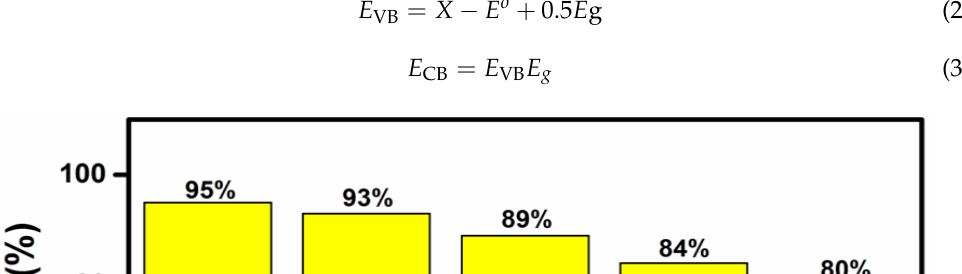
5.79 eV for Mn-ZnO [37], E o is the hydrogen scale free electron energy which has ∼ 4.5 eV value, and E g is the energy band gap. As Mn-ZnO ( − 0.25 eV vs. NHE) has more conduction band potential as compared to Ag 3 PO 4 (+0.329 eV vs. NHE), electrons were shifted from the conduction band of Mn-ZnO toward the conduction band of Ag 3 PO 4 [38,39]. Moreover, holes were shifted from the valence band of Mn-ZnO (+2.83 eV vs. NHE) to the valence band of Ag 3 PO 4 (+2.589 eV vs. NHE) due to p–n heterojunctions [40]. In this way, the formed Type-II p–n junction between Ag 3 PO 4 and Mn-ZnO facilitated the charge carrier transportation efficiently, and photocatalytic activity was